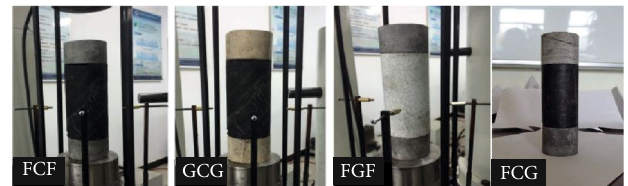
Figure 11: The physical map of the combined body.